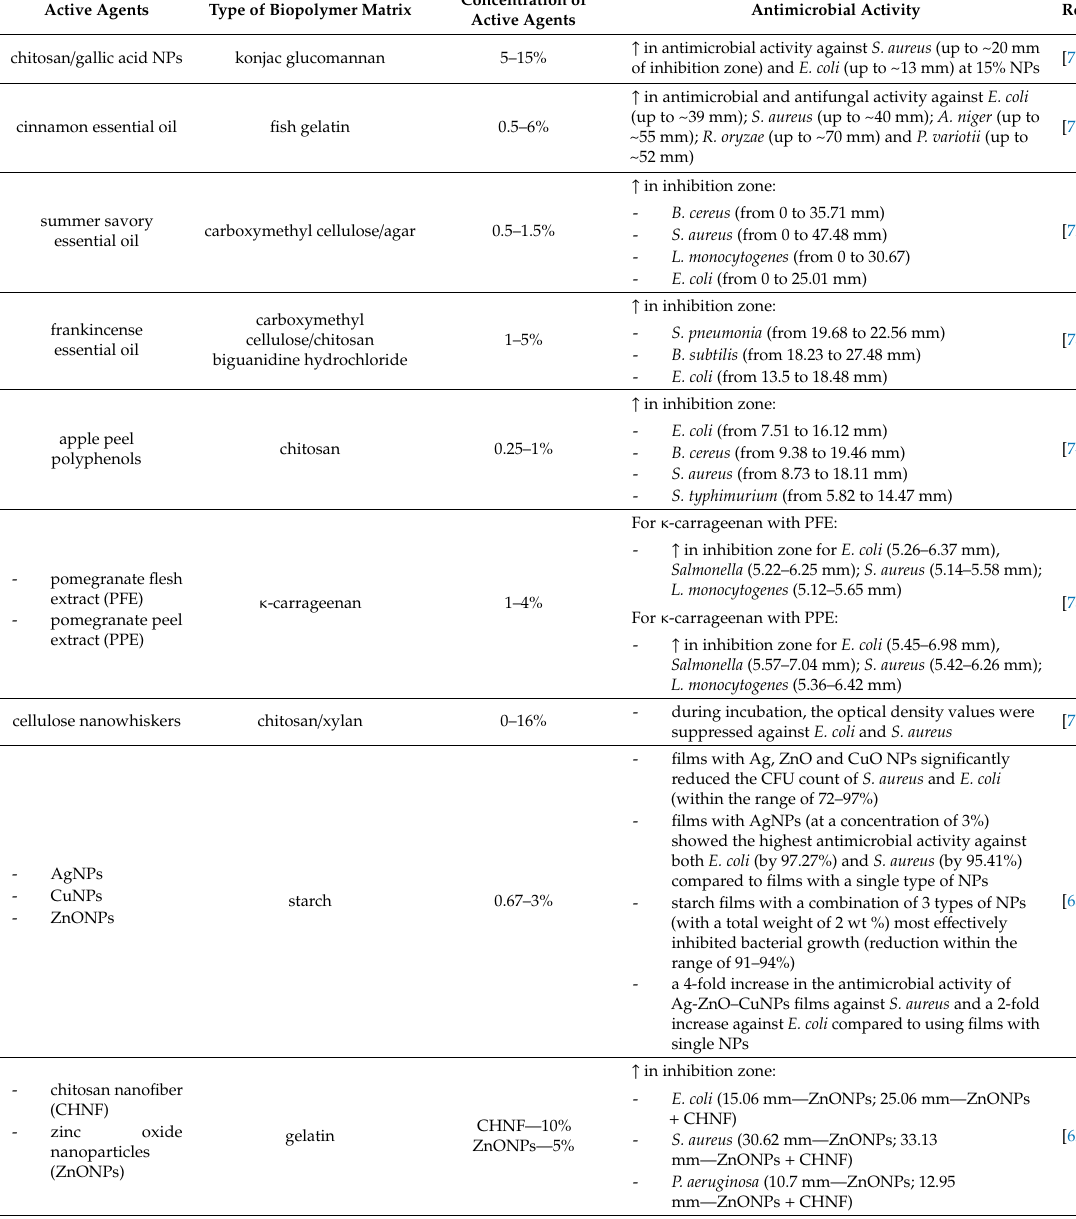
Table 2. A summary of biopolymer films with antimicrobial